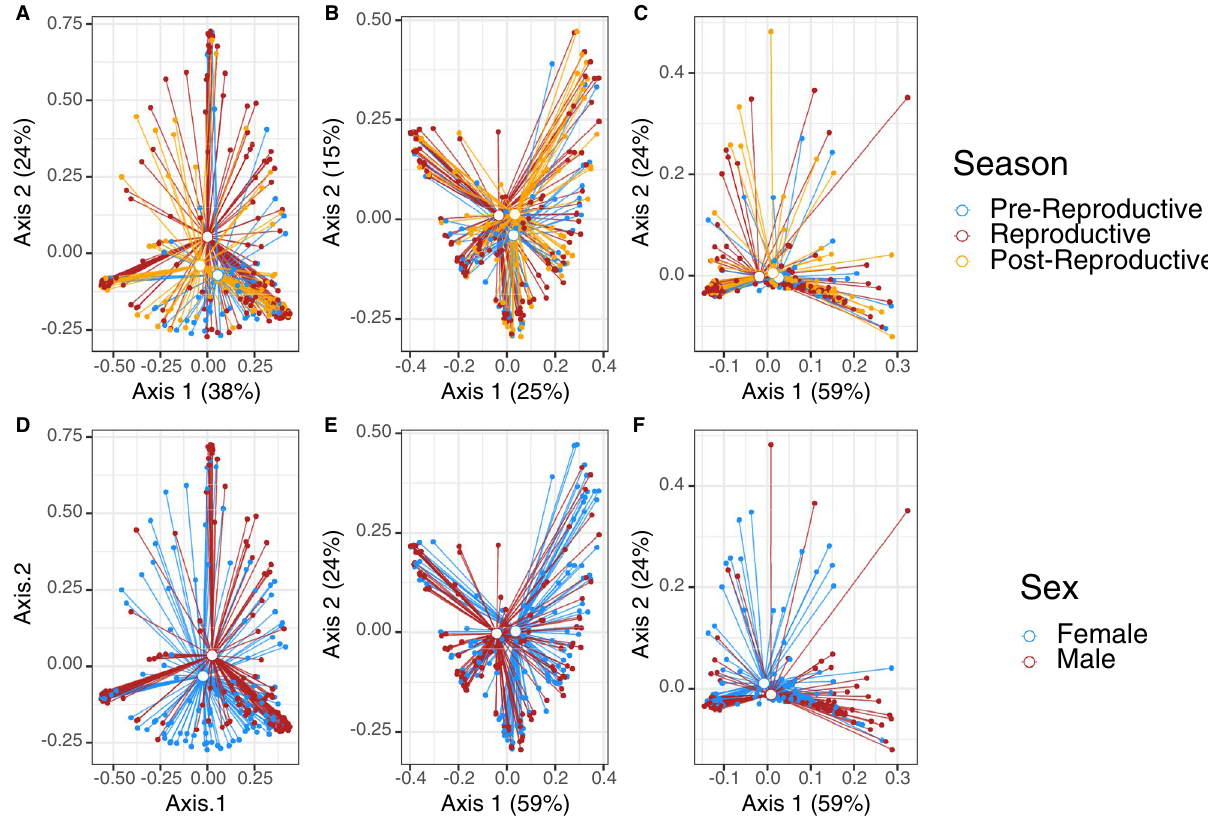
Figure 2. PCoA plots for all cloacal microbiomes, based on ( A ) Bray–Curtis, ( B ) unweighted UniFrac, and ( C ) weighted UniFrac distances. Open dots represent the centroids of each group. Solid dots represent each sample. Segments connect centroids to each sample. Colors represent either season of the active period ( A – C ) or sex ( D – F